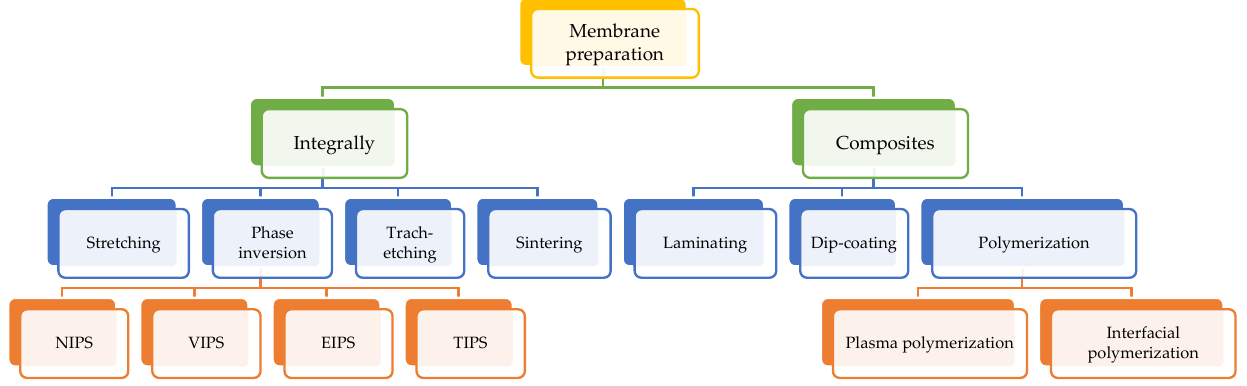
Figure 1. Membrane preparation techniques. Reproduced from [41], Institute of Research and Jour- nals, 2018.